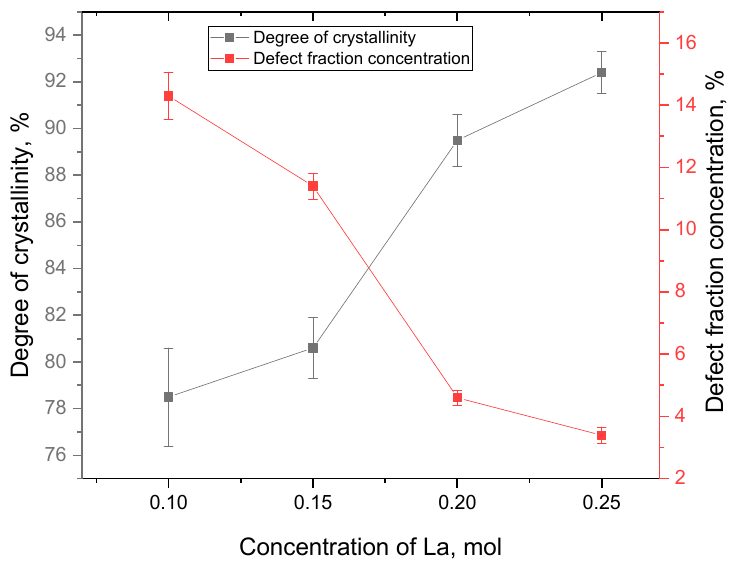
Figure 5. Results of changes in the crystallinity degree and the defect fraction concentration in the composition of ceramics with variation of the components.